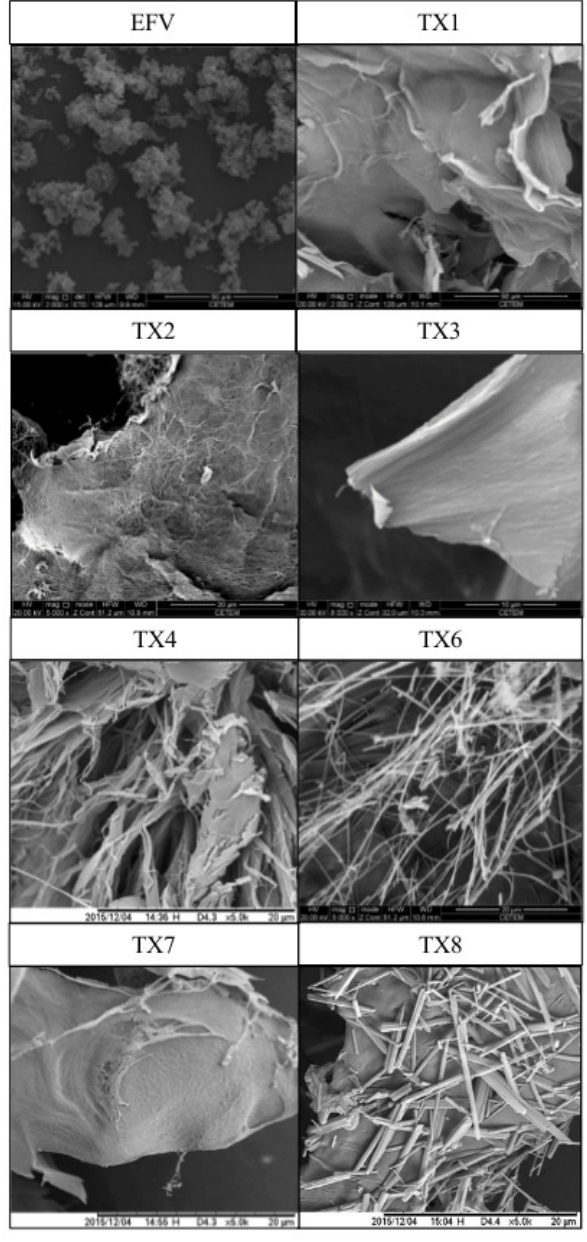
FIGURE 2 - Photomicrographs from SEM analysis. Pictures of different samples, obtained through microscopy